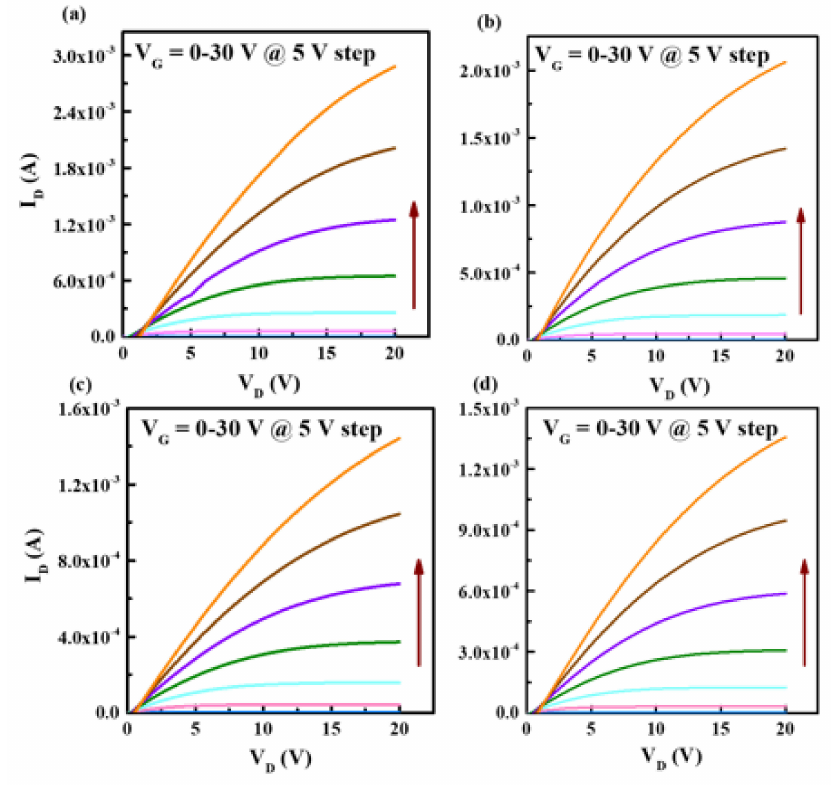
Figure 6. Output characteristics measured for IPO TFTs with P ratios of ( a ) 0%, ( b ) 3%, ( c ) 6%, and ( d )